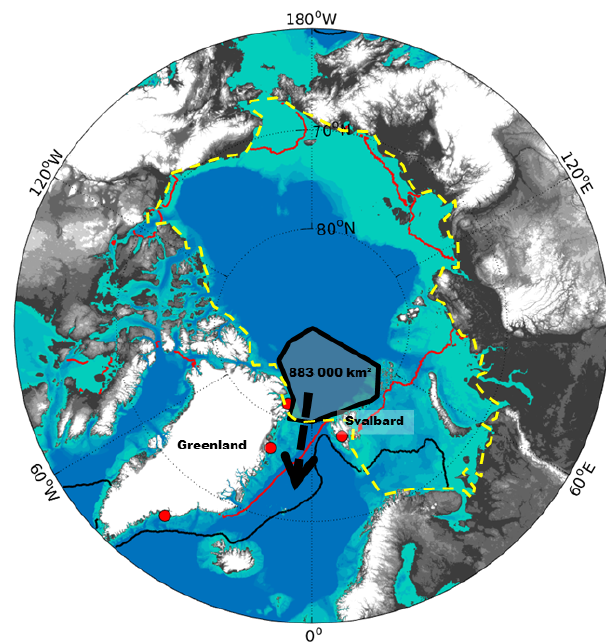
Figure 1. The Arctic Ocean and surrounding shelf and land areas. The large black arrow shows the location of Fram Strait, and the red circles show the positions of the meteorological stations with sea level pressure observations. The 1935–2014 mean positions of the mid-month sea ice extent are plotted for September (red) and March (black). The 1935–2014 mean annually exported sea ice area (883000km 2 ) is illustrated by the polygon. The outer extent of the Arctic Ocean domain is drawn using the yellow dashed